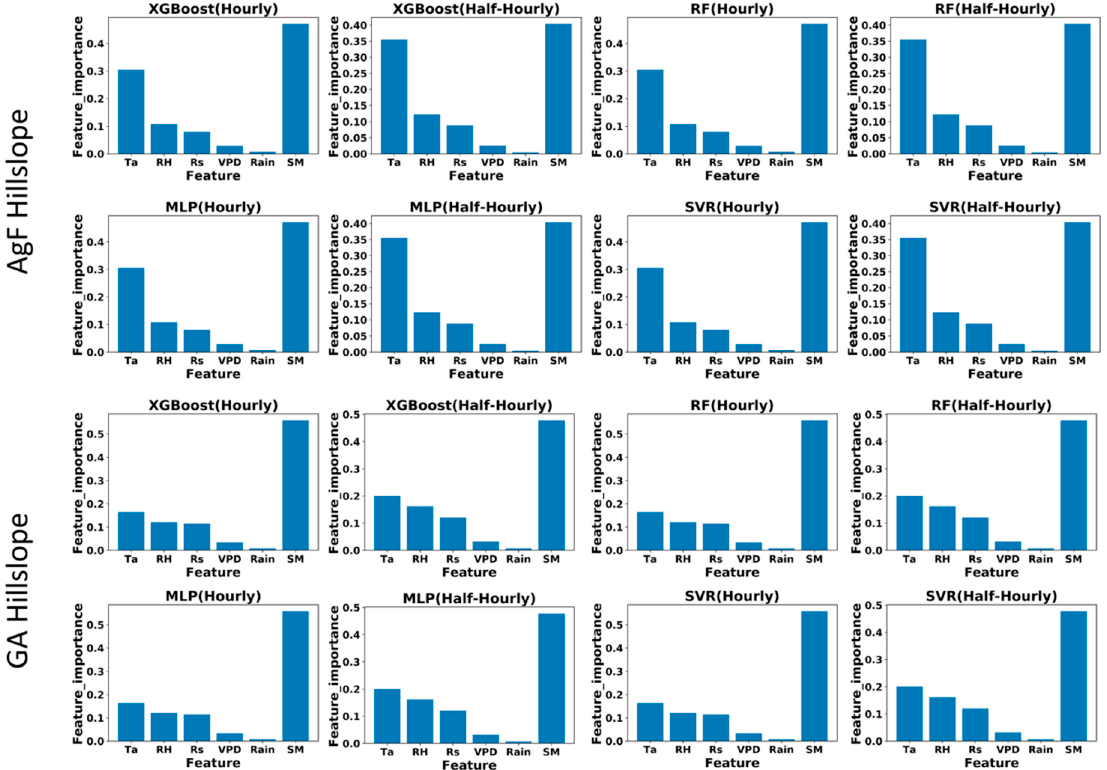
input nodes. input nodes. Water 2020 , 12 , x FOR PEER REVIEW